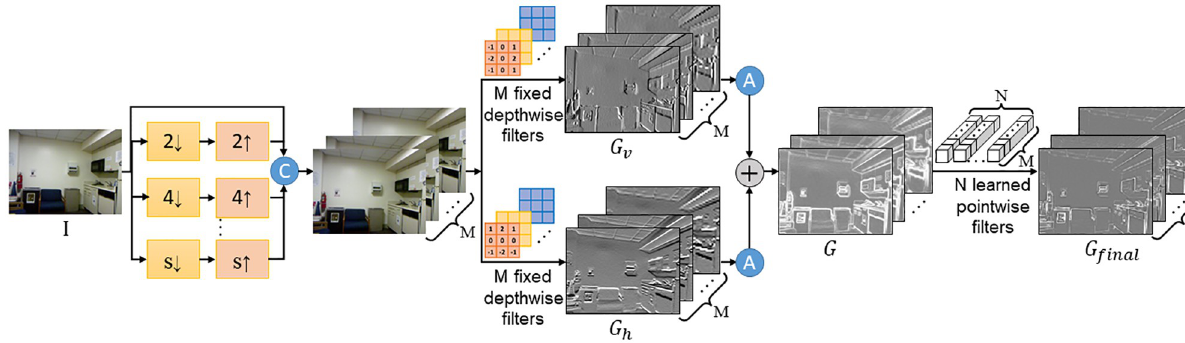
Fig 2. The architecture of the multi-scale gradient